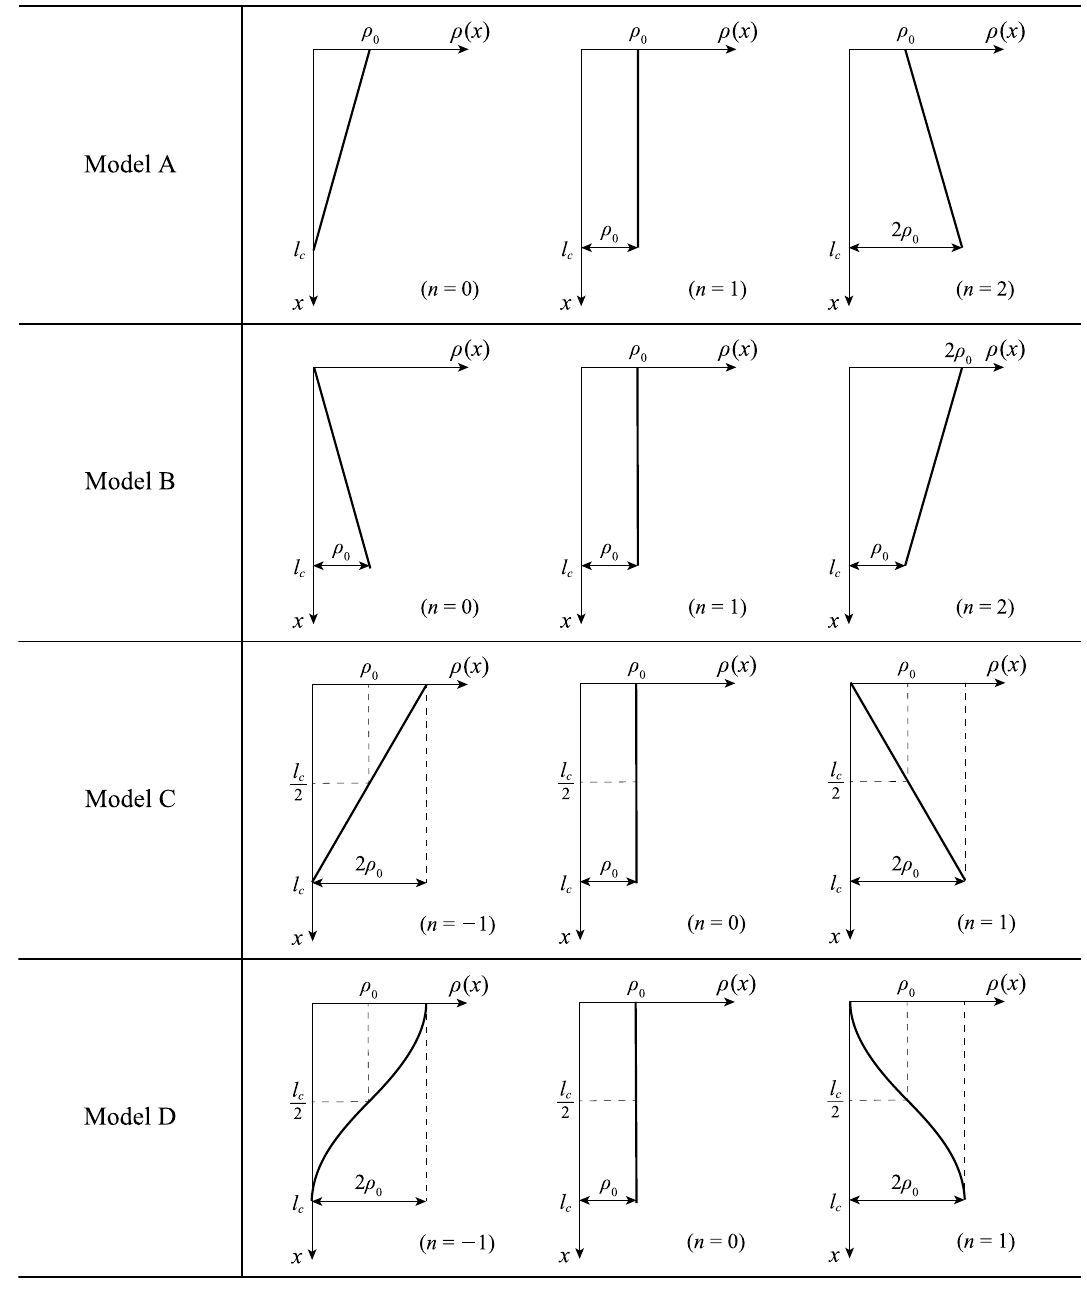
Figure 1. Density functions for models A, B, C, and D,